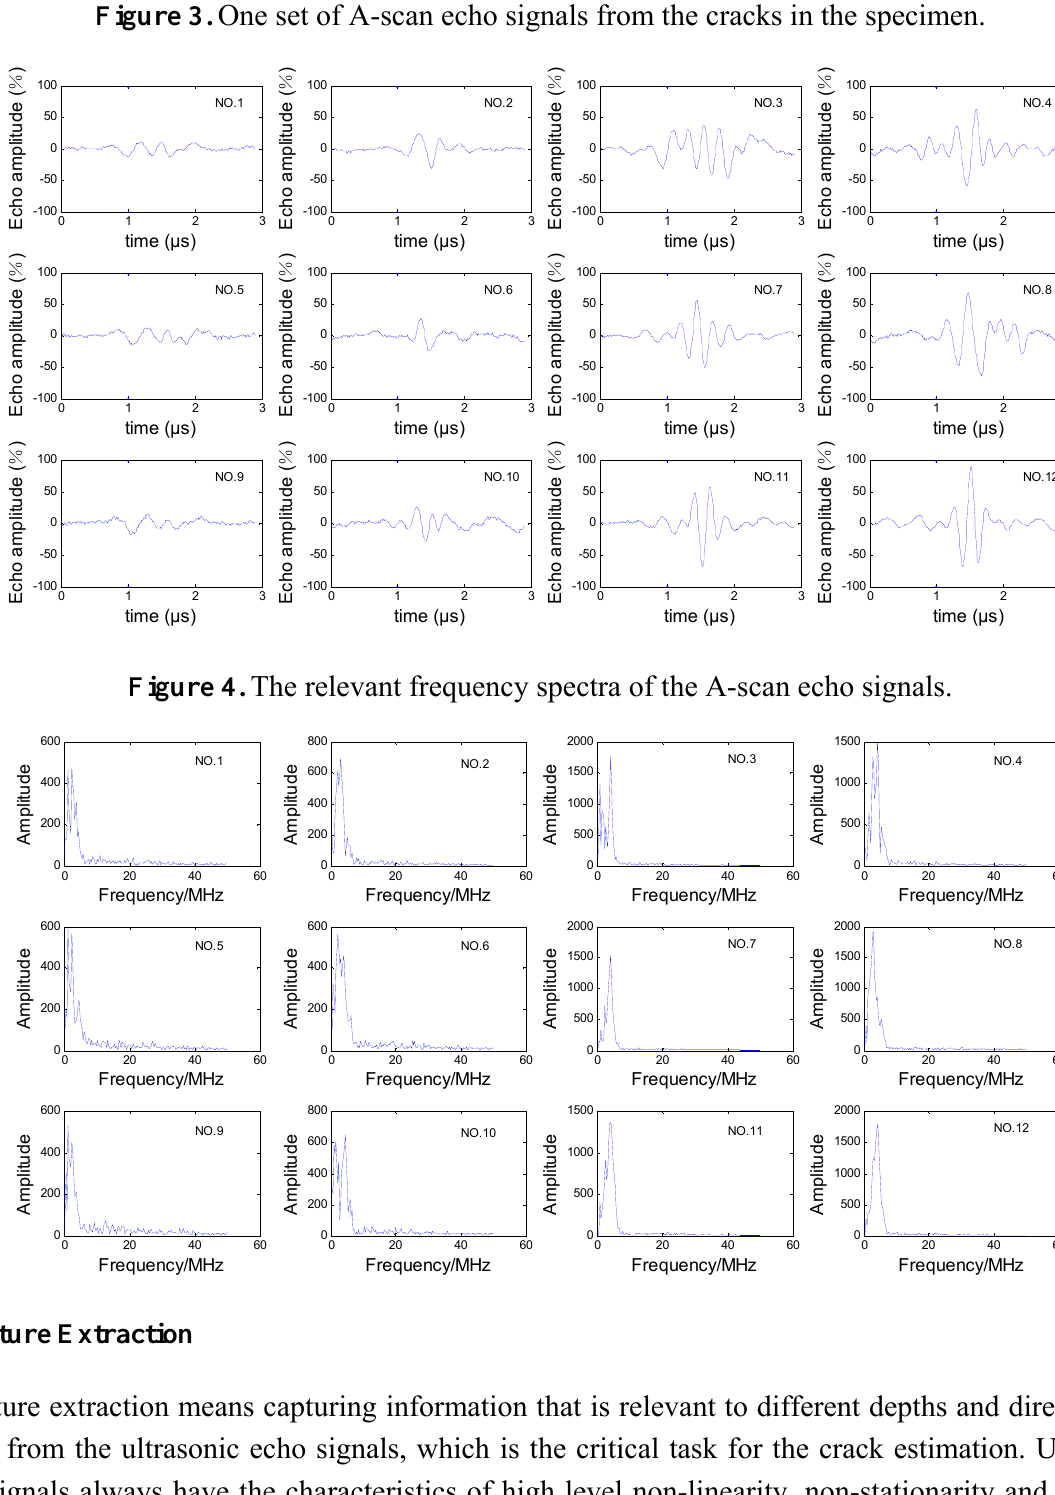
Figure 3. One set of A-scan echo signals from the cracks in the specimen.